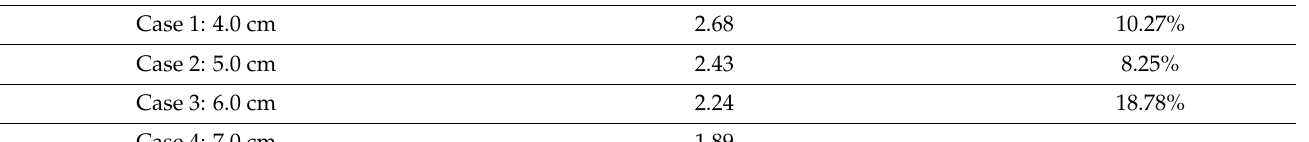
Table 2. Table of testing the water depths with productivity. Month of Measurement: October–November 2022. Average Daily Sunlight Used Hours: 9 h. Brackish Water Depths Were Tested Solar Radiation Density Range: 0 to 850 W/m 2 . Productivity (Liters per